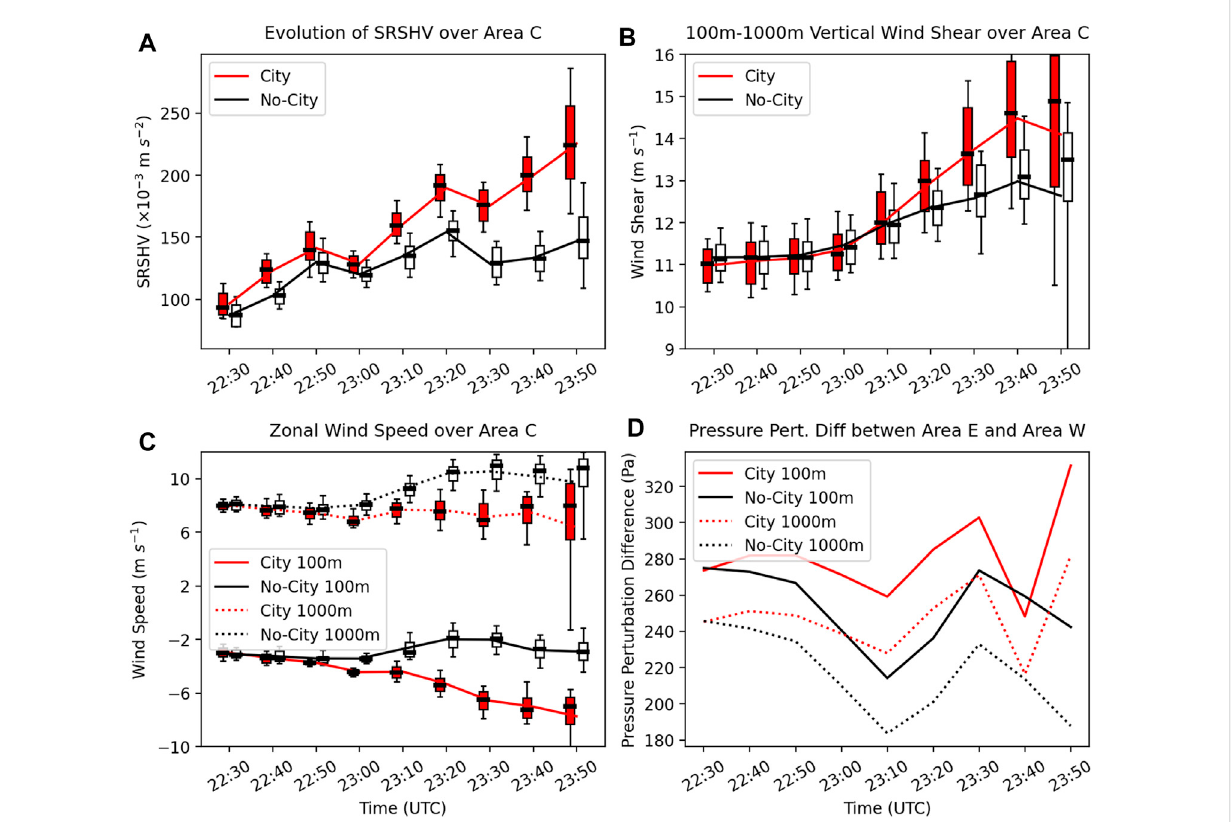
FIGURE 6 Comparison between Cityand No-Cityinthetemporal evolutionsof (A) SRSHV, (B) vertical windshearwithin the100m-1 kmlayerinarea C, (C) the zonalwind speedat100mand1 kminarea C(easterly isnegativeand westerlyispositive), and (D) thedifference inpressureperturbation between areaE and area W at 100 m and 1 km. The lines represent the domain average values, while the box plots show the 5th percentile value (lower whisker), 25th percentile value (bottom of the box), median value (center of the box), 75th percentile value (top of the box), and 95th percentile value (upper whisker) of all the grid elements within the selected area.